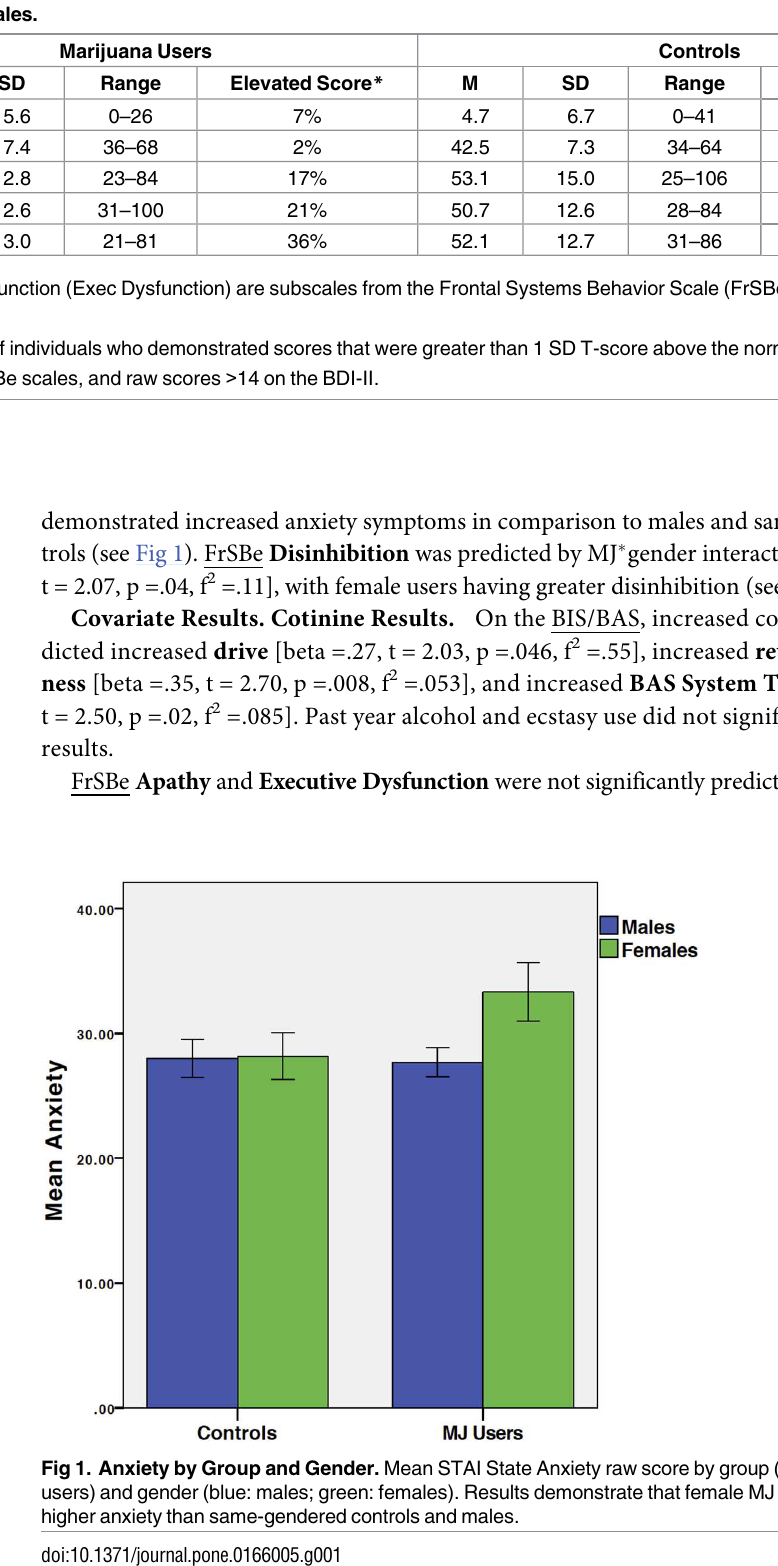
Fig 1. Anxiety by Group and Gender. Mean STAI State Anxiety raw score by group (left: controls; right: MJ users) and gender(blue: males; green: females). Results demonstrate that female MJ users have significantly higheranxiety than same-gendered controls and